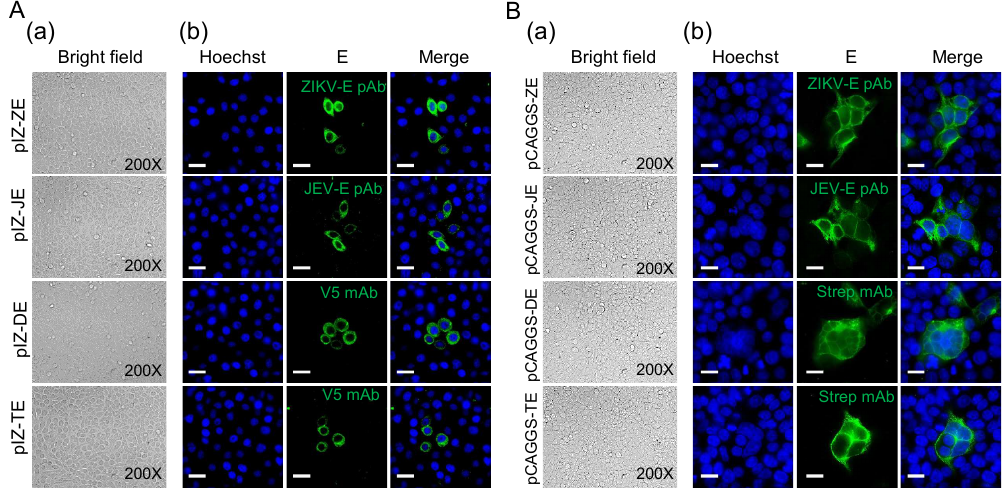
Figure 2. Transient expression of flavivirus E proteins. ( A ) Morphology of Sf9 cells transfected with pIZ-ZE, pIZ-JE, pIZ-DE, and pIZ-TE. ( a ) The bright field of transfected cells at 48 h p.t.; ( b ) E protein expression was detected by IFA at 48 h p.t. E proteins (green) were detected with indicated antibodies. Nuclei were stained with Hoechst as shown in blue. Bars, 10 µ m. ( B ) Morphology of 293 T cells transfected with pCAGGS-ZE, pCAGGS-JE, pCAGGS-DE, and pCAGGS-TE. At 18 h p.t, cells were treated with low pH (6.0) DMEM for 30 min and then cultured using DMEM (normal pH) for 18 h. ( a ) The bright field of transfected cells 18 h after low pH treatment; ( b ) E protein expression was detected by IFA 18 h after low pH treatment. E proteins (green) were detected with indicated antibodies. Nuclei were stained with Hoechst as shown in blue. Bars, 10 µ